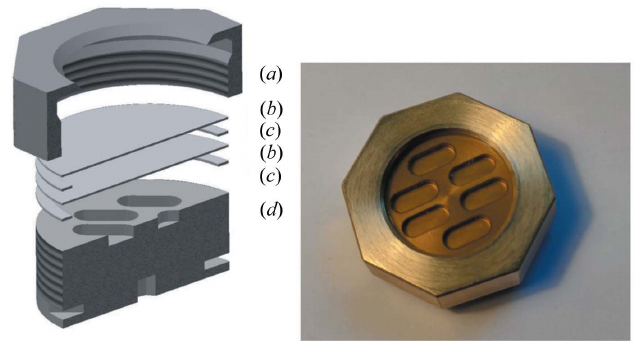
Figure 4 Left image – an exploded-view 3D CAD drawing of the sample cell assembly. From top to bottom: ( a ) cap nut, ( b ) KAPTON disk, ( c ) TEFLON gasket, ( b ) KAPTON disk, ( c ) TEFLON gasket, ( d ) cell body. Right image – a top view of a sealed sample cell with six sample cavities (outer diameter ’ 30